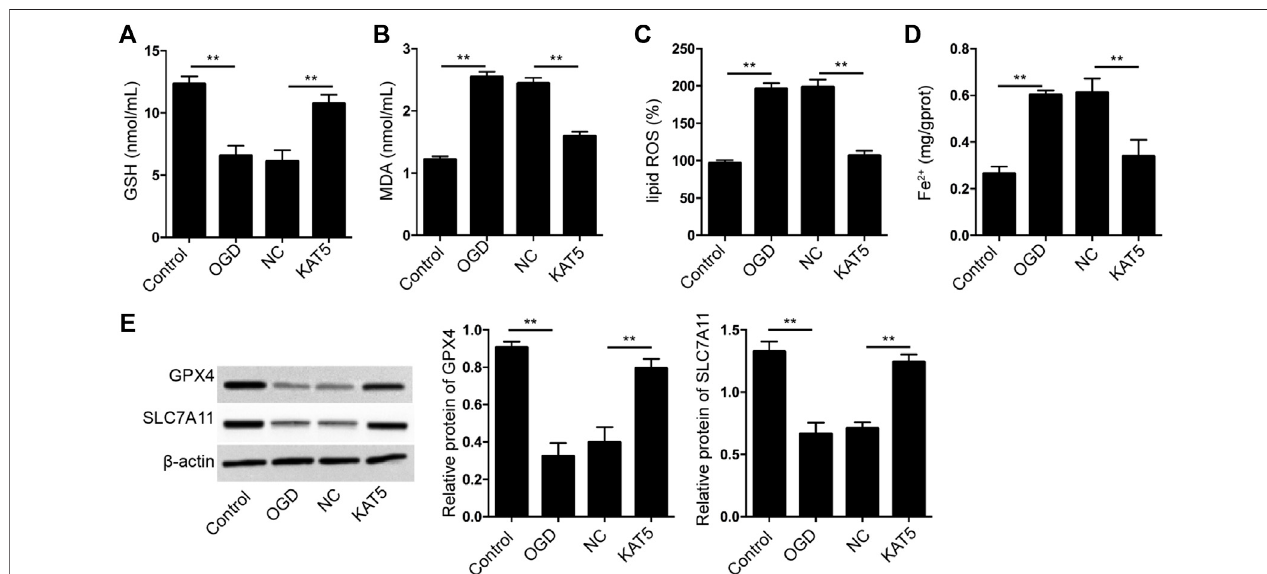
FIGURE 6 | KAT5 reduces OGD-induced cardiomyocyte ferroptosis . (A – E) The OGD-treated H9c2 cells were treated with KAT5 overexpressing plasmid. The levels of GSH (A) , MDA (B) , lipid ROS (C) , and Fe 2+ (D) were analyzed. (E) The expression of GPX4 and SLC7A11 was detected by Western blot analysis and was normalized on the expression of β -actin. Data are presented as mean ± SD. Statistic signi fi cant differences were indicated: ** p < 0.01.